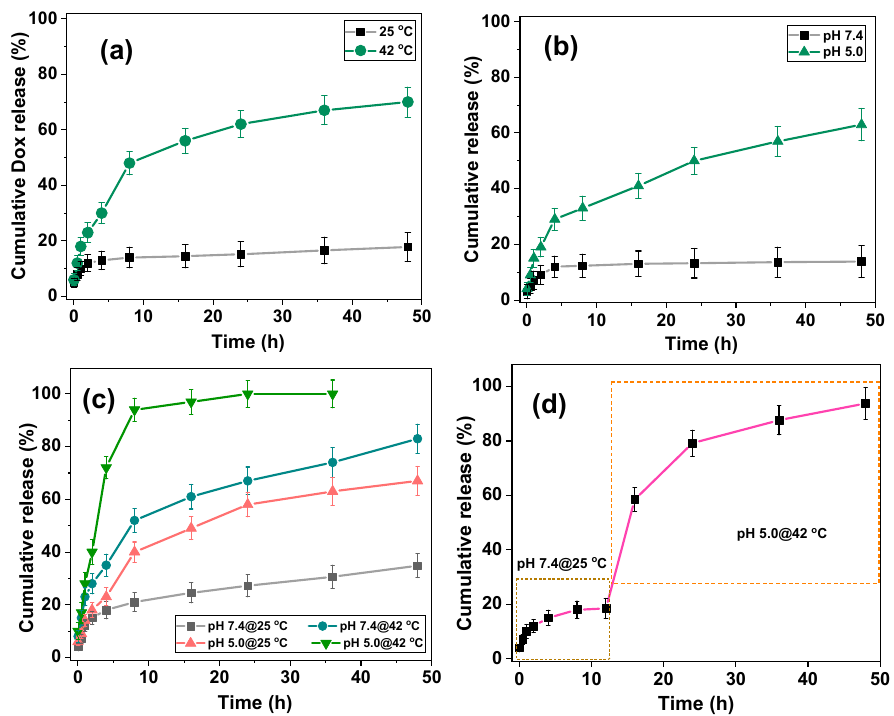
Figure 6. In vitro Dox release from the MS@Dox/PNIPAm-PAAm NPs at ( a ) different temperatures, ( b ) different pH, and ( c ) the combined pH and temperature, respectively. ( d ) pH- and temperature- dependent in vitro Dox release at the combined pH and temperature conditions.